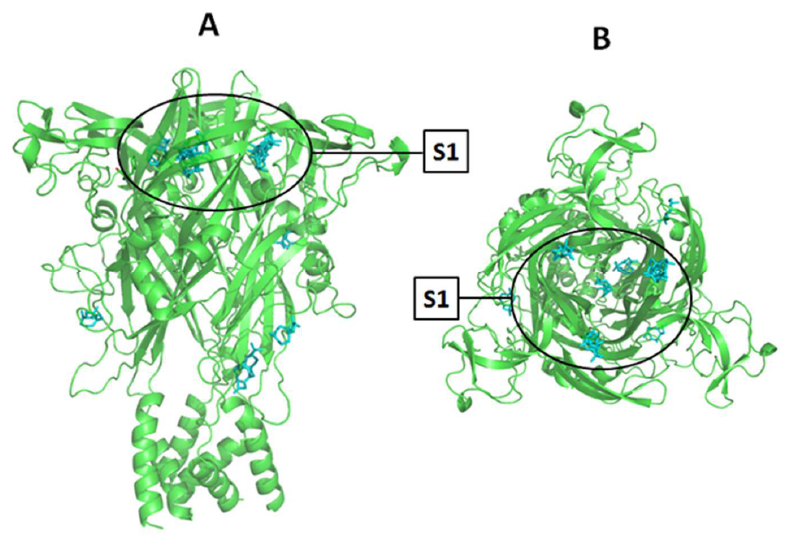
Figure 8. Superposition of all β-caryophyllene conformations generated by the AutoDockVina against the P2X7R macromolecule. The binding site 1 (upper body domain of P2X7R pore) is highlighted and assigned as S1: ( A ) front view, ( B ) top view.